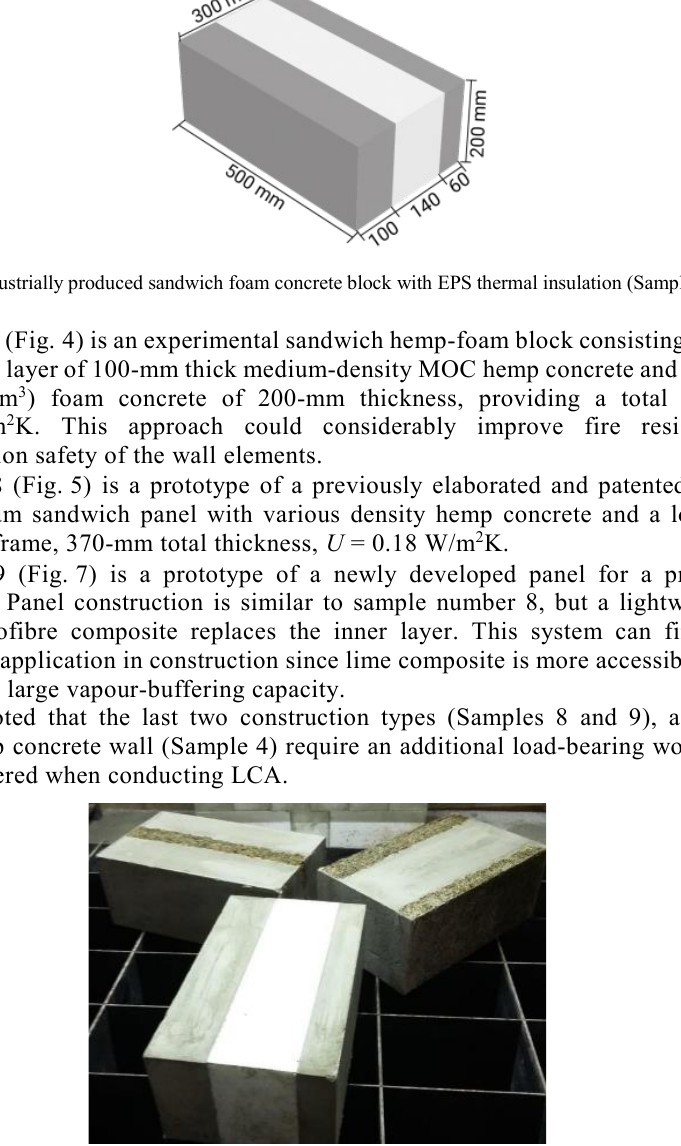
Fig. 4. Experimental foam blocks (industrially produced): sample 6 (at the front), sample 7 hemp-foam concrete-hemp (Sample 7, on the